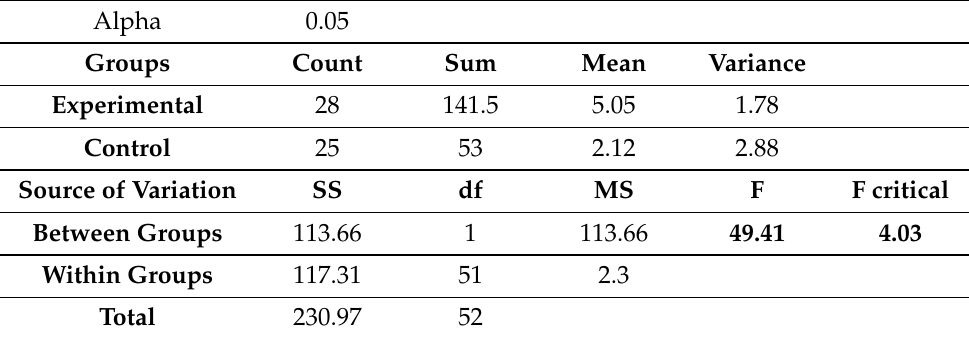
Figure 16. Correct answers in total per task (l) and quartile graphs for points gained (r). Table 6. ANOVA (single factor) results for Boolean logic block achievement tests